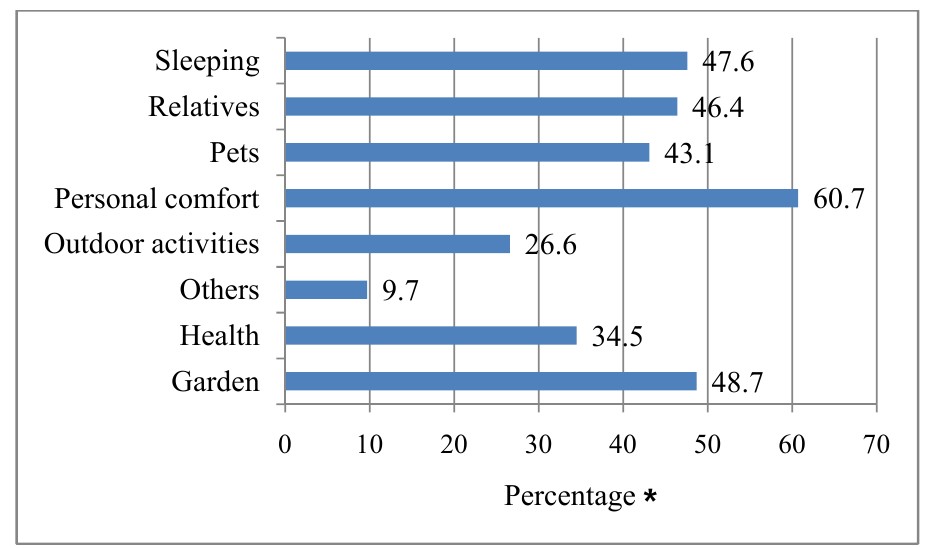
Figure 5. Respondents concerns during a heat wave. Q5. What are you concerned about during a heat wave? (multiple responses).